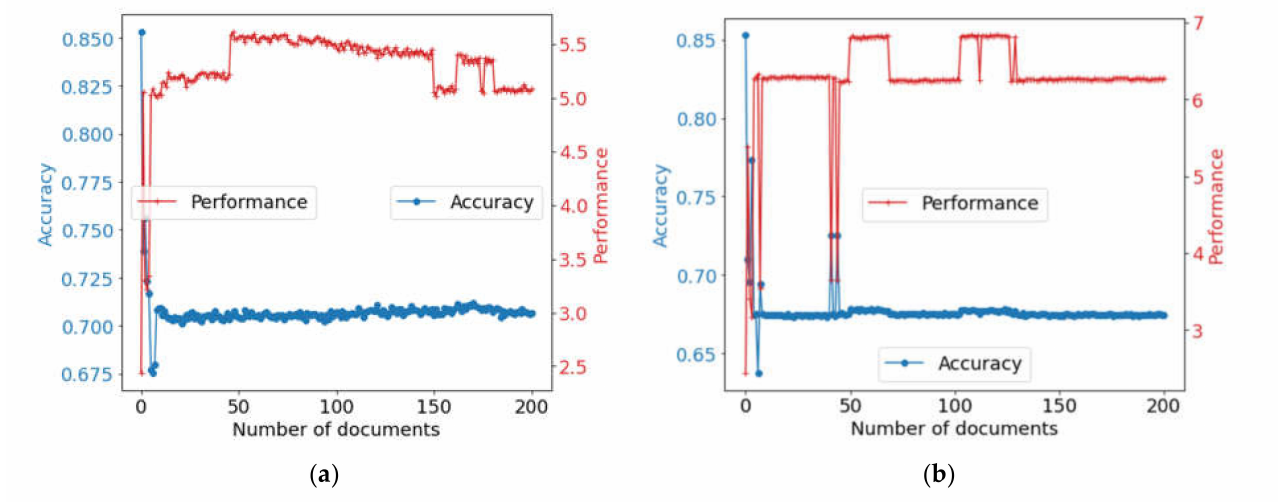
Figure 9. Case 2 auctioning results: ( a ) prioritization by accuracy, ( b ) prioritization by